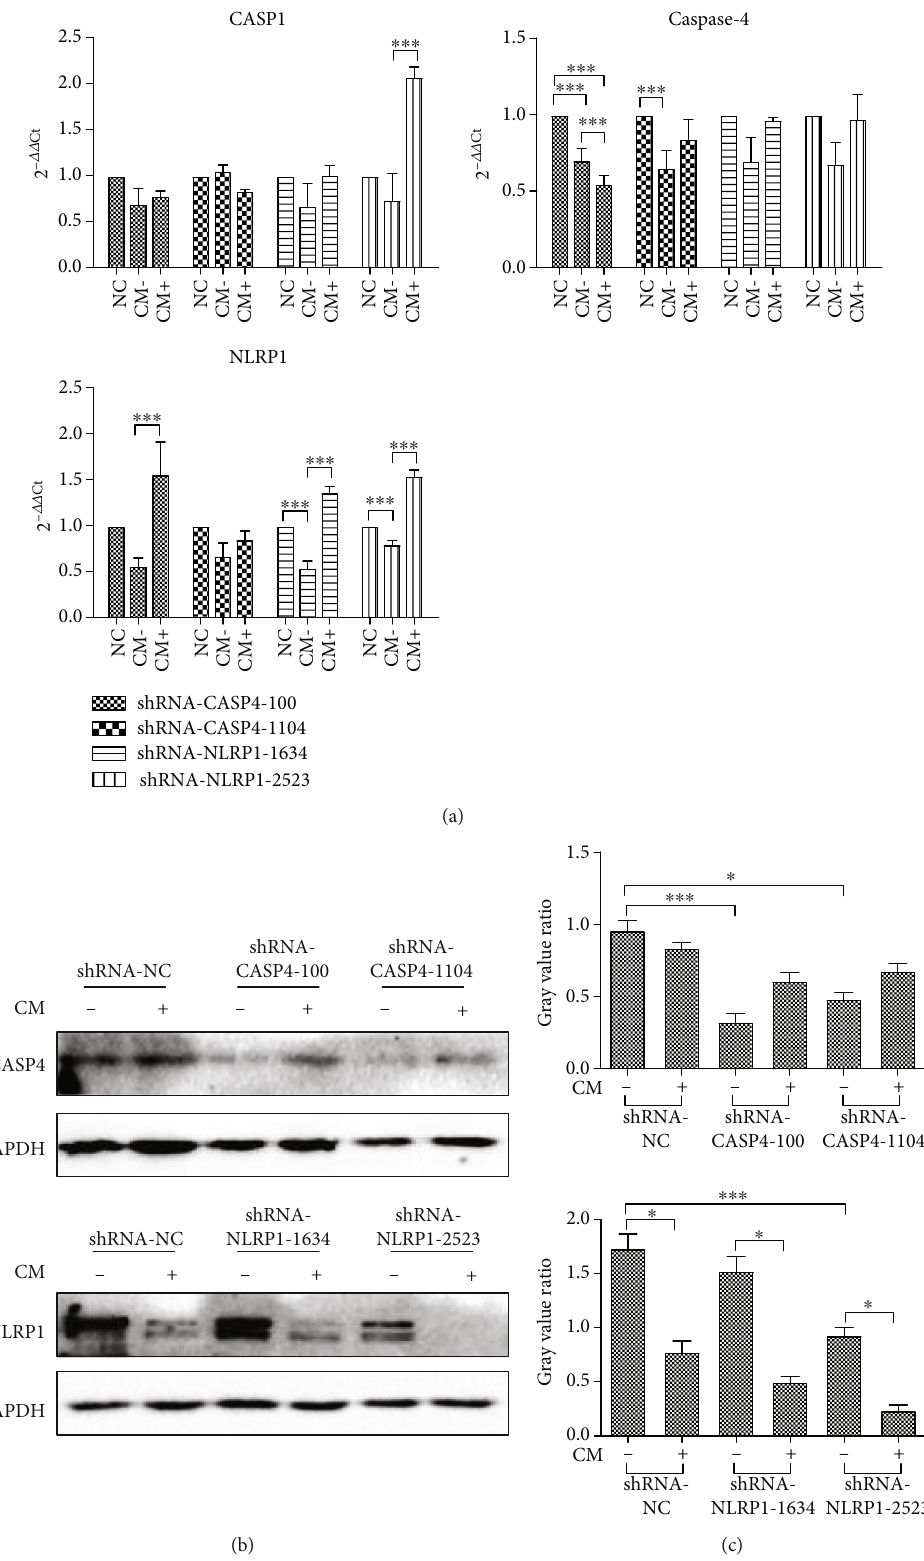
Figure 5: Detection of genes expression. (a) The q-PCR results of pyroptosis-related genes. Data are presented as Ct (2 - △△ Ct ) relative to control. Data are presented as mean ± S : D : , n = 3 . ∗ P < 0 : 05 , ∗∗ P < 0 : 01 , and ∗∗∗ P < 0 : 001 . (b) The results of western blotting. (c) The gray value ratio of western blotting results. NC: negative control. CM-: cells were collected after transfection with shRNA vector for 72h. CM+: cells were collected after transfection with shRNA vector for 72h and treated with hUCMSC-CM for 24h. ∗ P < 0 : 05 , ∗∗ P < 0 : 01 , and ∗∗∗ P < 0 : 001